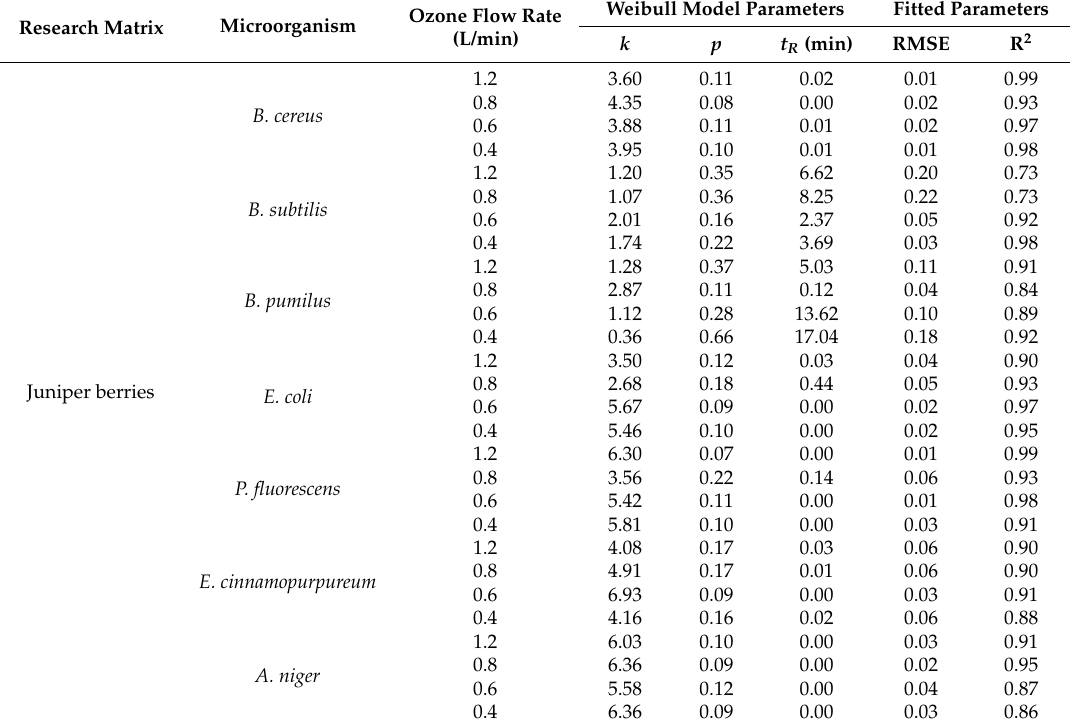
Table 1. Weibull model and fitted parameters for reductions of B. cereus , B. subtilis , B. pumilus , E. coli , P. fluorescens , E. cinnamopurpureum , and A. niger on the juniper berry matrix after ozone treatment in a dynamic